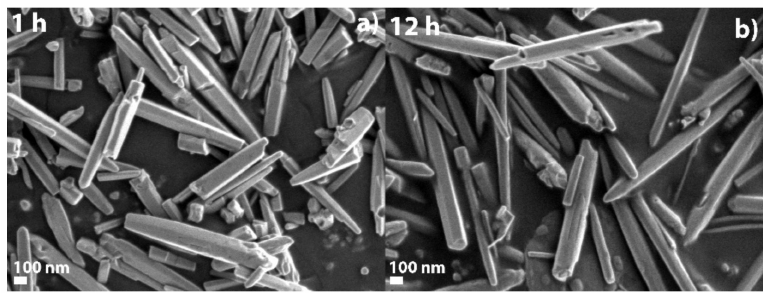
Figure 2. SEM images of ZnO-(Py)NRs synthesized for ( a ) 1 and ( b ) 12